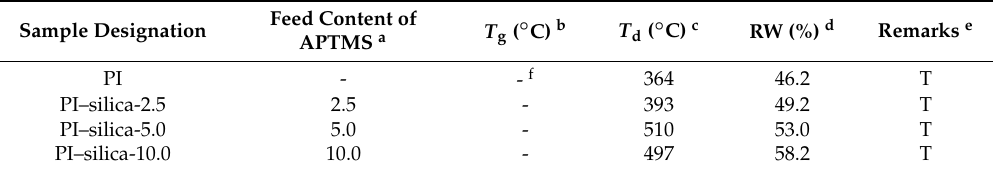
Table 1. Compositions, glass transition temperatures ( T g ), decomposition temperatures ( T d ), and residual weight percentages of the PI and PI–silica composite films.